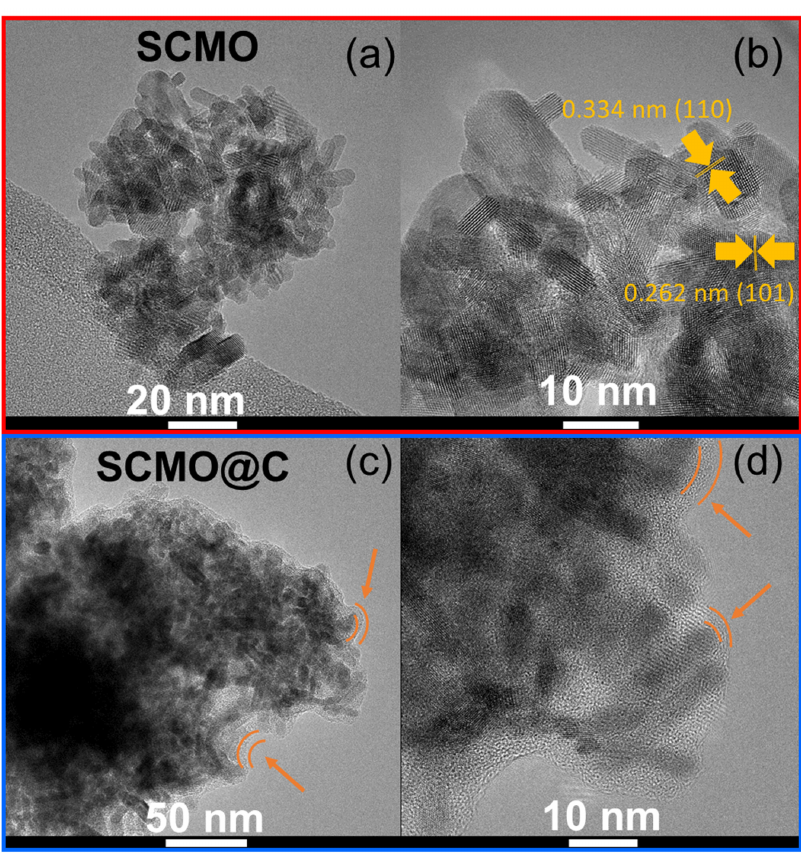
Figure 1. Transmission electron micrographs of ( a , b ) SCMO and ( c , d ) SCMO@C at different magnifications. The yellow lines in ( b ) highlight the lattice fringes of (110) and (101) planes; orange lines and arrows in ( c , d ) indicate an amorphous carbon layer on the nanoparticle surface. The homogeneous distribution of carbon was corroborated by the additionally performed EDX mapping (Figure 2). However, an EDX analysis also revealed that a cavity in the centre of the nanoparticle agglomerate showed a higher carbon concentration, indicating that the initial cavity was “filled” with carbon. More importantly, EDX mapping showed that the two dopants Co and Mn were homogeneously dispersed in the sample along with Sn. The EDX analysis also provided an estimation of the TM contents: For Co, the calculated value of about 0.051 (referring to the substitution of Sn in Sn 1-x- y Co x Mn y O 2 , i.e., x for Co; note that we do not consider the oxygen vacancies in this formula as the result of the aliovalent TM doping) is in good agreement with the expected concentration with regard to the initial metal ratio of the precursors (also considering the experimental error of this method), while it is a little lower for Mn with about 0.032 (i.e., y in Sn 1-x-y Co x Mn y O 2 ). This might indicate that the incorporation of Co into the SnO 2 structure is slightly favoured compared with Mn.